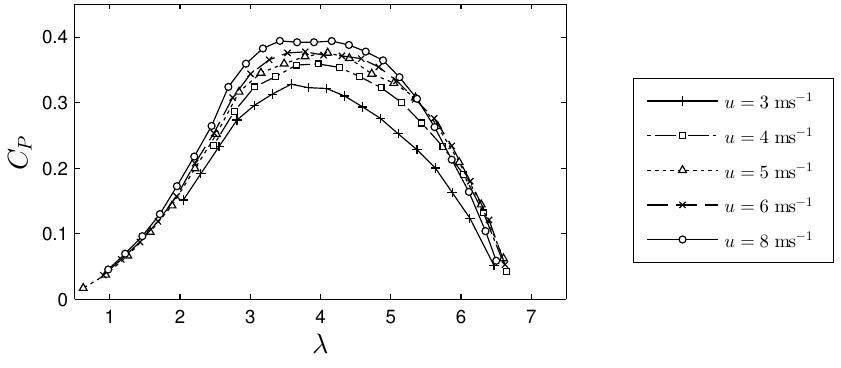
Figure 11. Variation of the power coefficient C P of the miniature turbine with the tip-speed ratio λ at different free-stream incoming